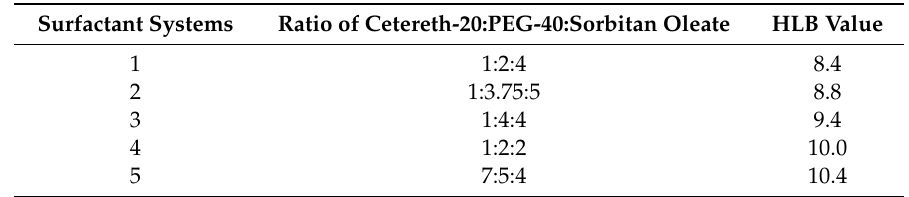
Table 3. Non-ionic surfactant systems including Cetereth-20, PEG-40 castor oil, and sorbitan oleate varied by ratio for modifying five di ff erent hydrophile-lipophile balance (HLB)